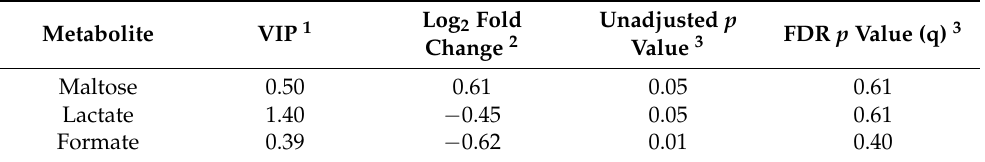
Table 2. Significant ( p ≤ 0.05) associations between relative concentrations of metabolites and delivery mode.